Question: What style of plot is this figure drawn as?
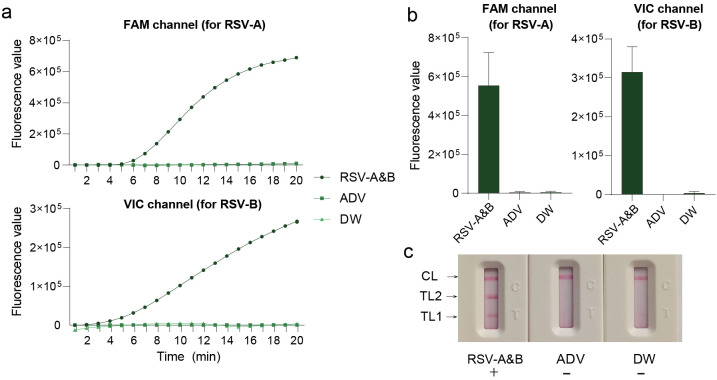
Answer: line